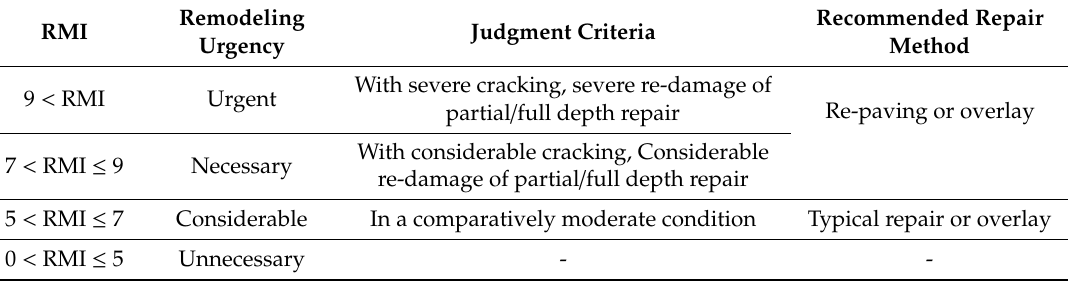
Table 1. Remodeling index (RMI) urgency criteria